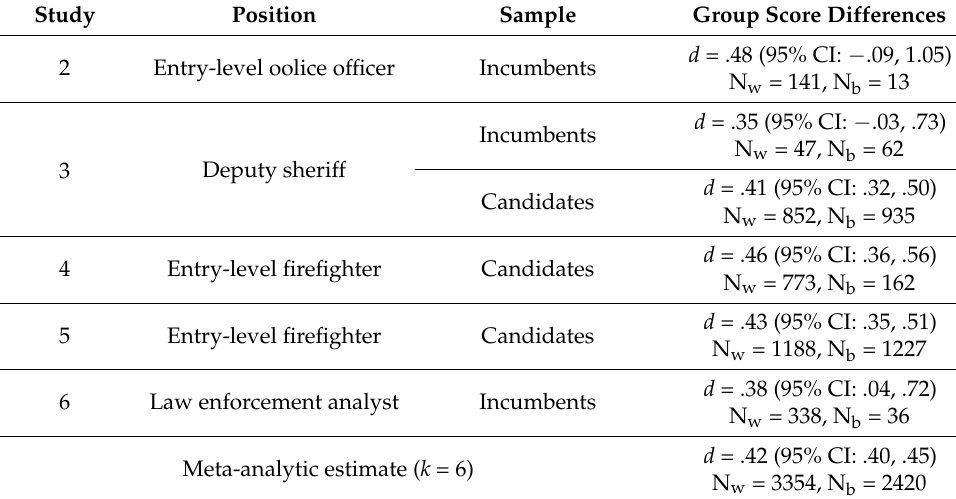
Table 2. Group score differences in public safety